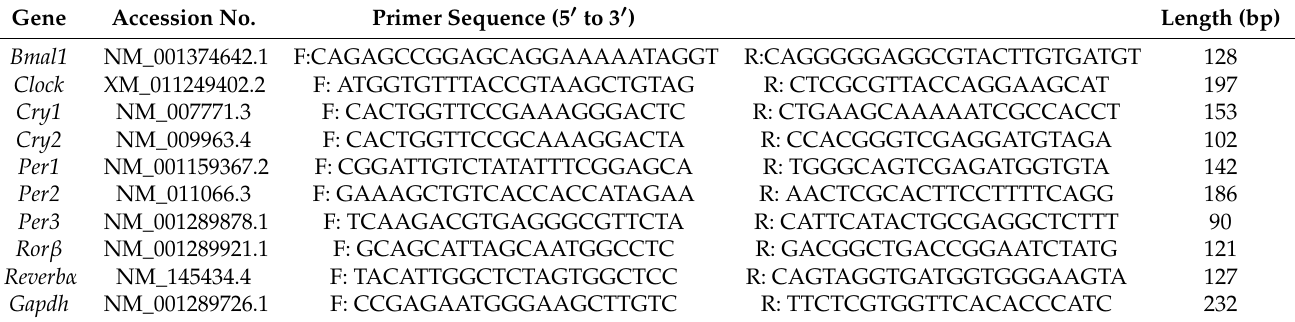
Table 1. Primers used for real-time PCR analysis and expected product